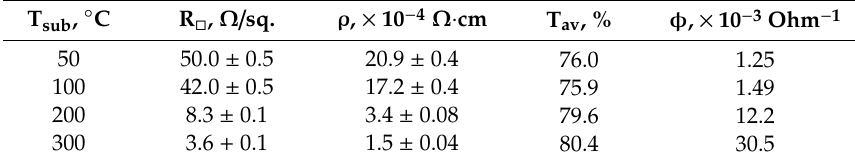
Table 1. Measured sheet resistance R (cid:3) , calculated film resistivity ρ = R (cid:3) × h, average transmittances T av in the range of 380–760 nm, and figure of merit φ = (T av ) 10 / R (cid:3) of the ITO glass. T sub , ◦ C R (cid:3) , Ω /